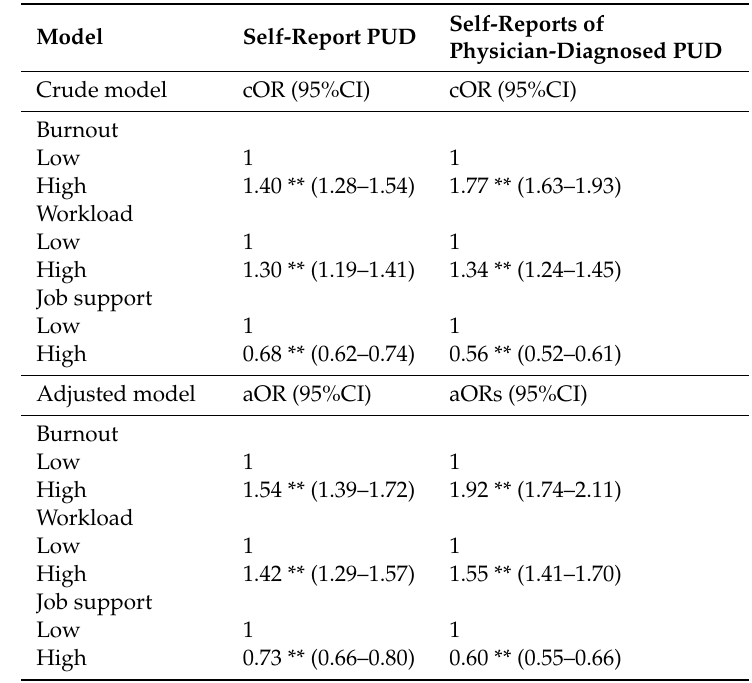
Table 4. PUD reported by participants and self-reports of physician-diagnosed a ff ected by burnout, workload, and job support, using multiple logistic regression adjusted for groups, educational level, marital status, duration of job, levels of employing government, manager, smoking, alcohol, and betel nut